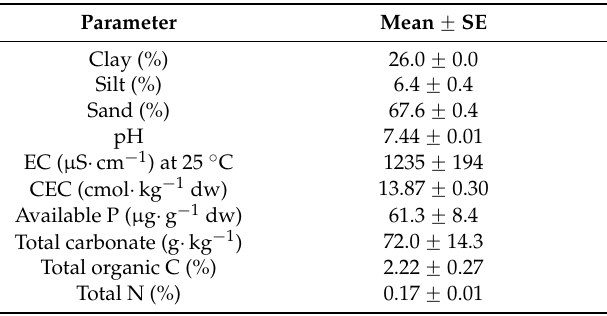
Table 1. Characteristics of soil used in this study ( n =